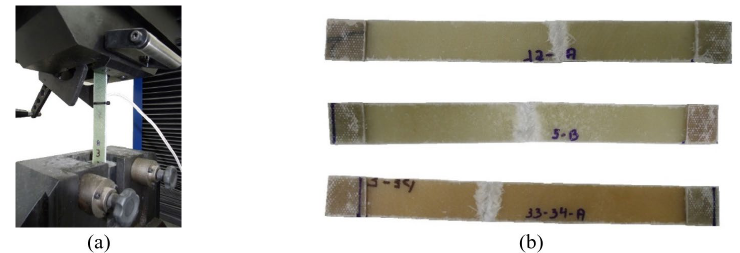
Figure 5. Ultimate tensile stress test: (a) test execution; (b) specimens after failure.